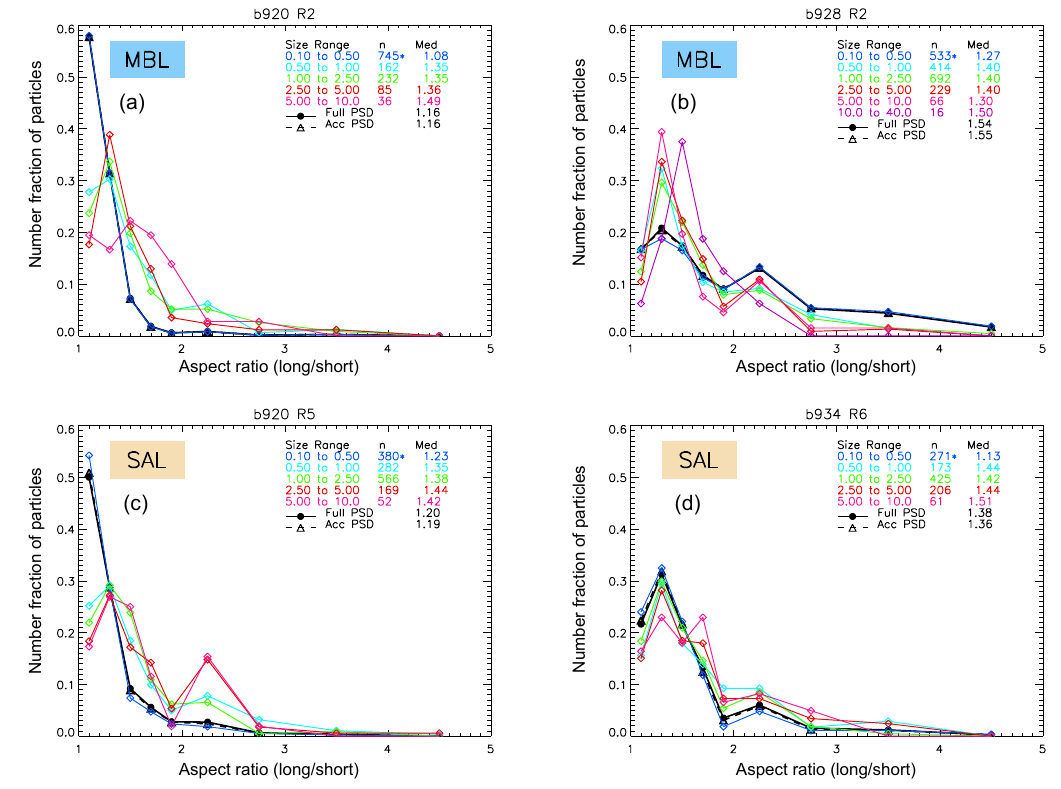
Figure 9. Number fraction of particles as a function of aspect ratio from filter sample analysis for the same four SLRs as shown in Fig. 7, as a function of size (colours), for the full PSD (0.1–40µm, solid black) and accumulation mode PSD (0.1–2.5µm). An asterisk indicates numbers were scaled-up from value shown to allow for different substrate areas at the higher magnification. The top two panels are samples from the MBL without (a) giant particles and with (b) giant particles. Panels (c) and (d) are SAL samples. Data are not shown where the number of particles in a size range is under 10. In each panel, the size range (microns diameter) and the associated number of particles counted and median aspect ratio are